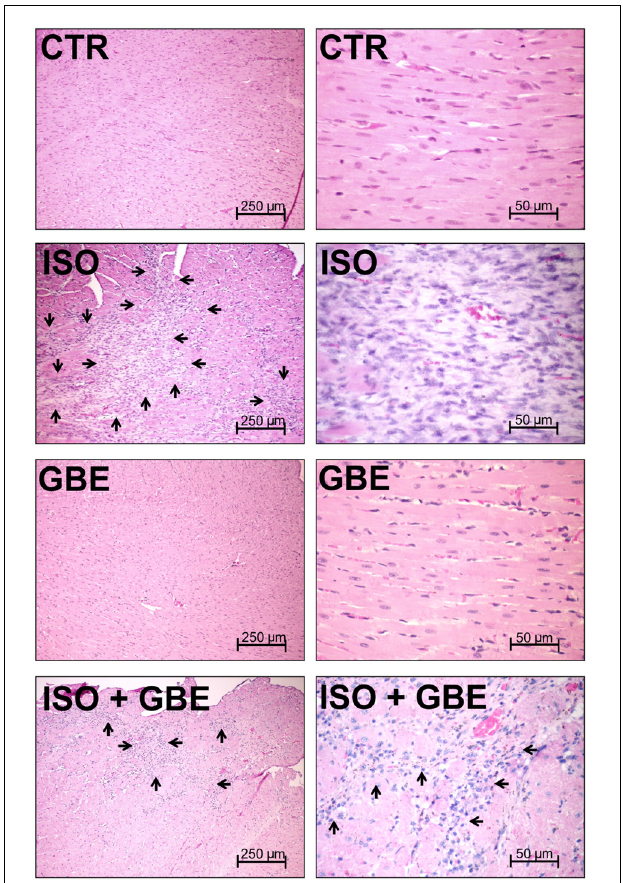
FIGURE 5 | Ginkgo biloba extract prevents pathological myocardial remodeling induced by chronic β -adrenergic stimulation. Histological sections of the left ventricle stained with hematoxylin-eosin in all of the groups evaluated. The CTR and Ginkgo biloba extract (GBE) groups demonstrate the cardiac striated muscle morphology. Areas of parenchymal replacement by fibrocellular connective tissue are highlighted by arrows. The ISO group demonstrates areas of parenchyma replacement by intense cardiac spindle cell proliferation (fibroblasts). Note that the ISO + GBE group presented a smaller area of parenchymal replacement by fibrocellular tissue ( n =